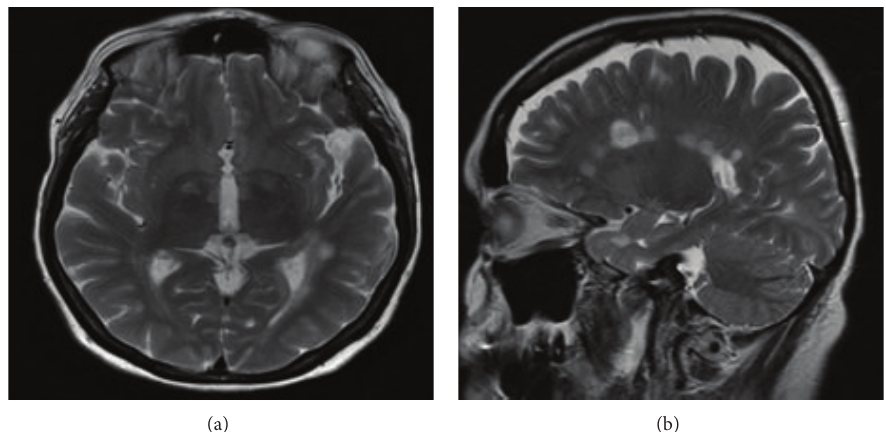
Figure 6: MR of the head; T2-weighted images (axial view (a) and sagittal view (b)) demonstrate numerous plaques in white matter